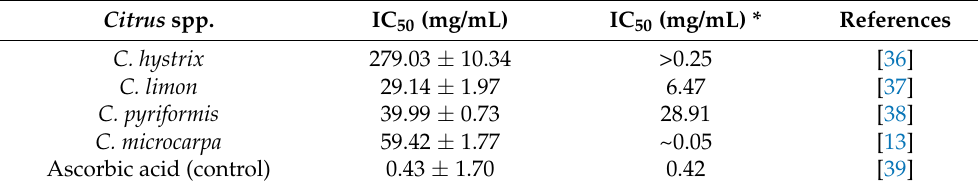
Table 2. Antioxidant activity of Citrus spp. leaf essential oils. Citrus